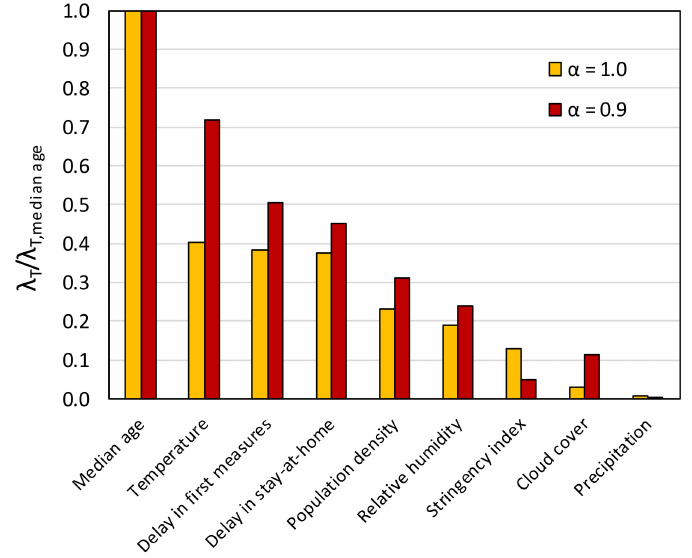
Figure 20. Rank of importance of causal variables based on Lasso and elastic net regression.